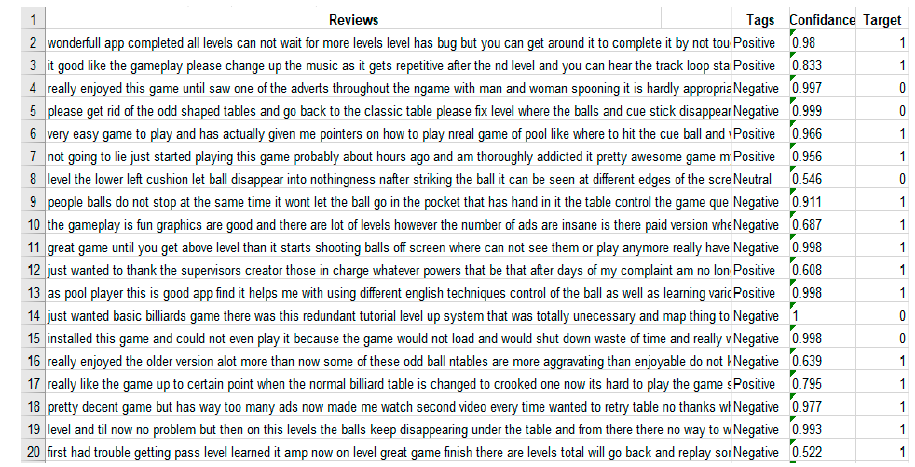
Figure 16. Final sentiment analysis results on Google Play reviews using the logistic regression algorithm.